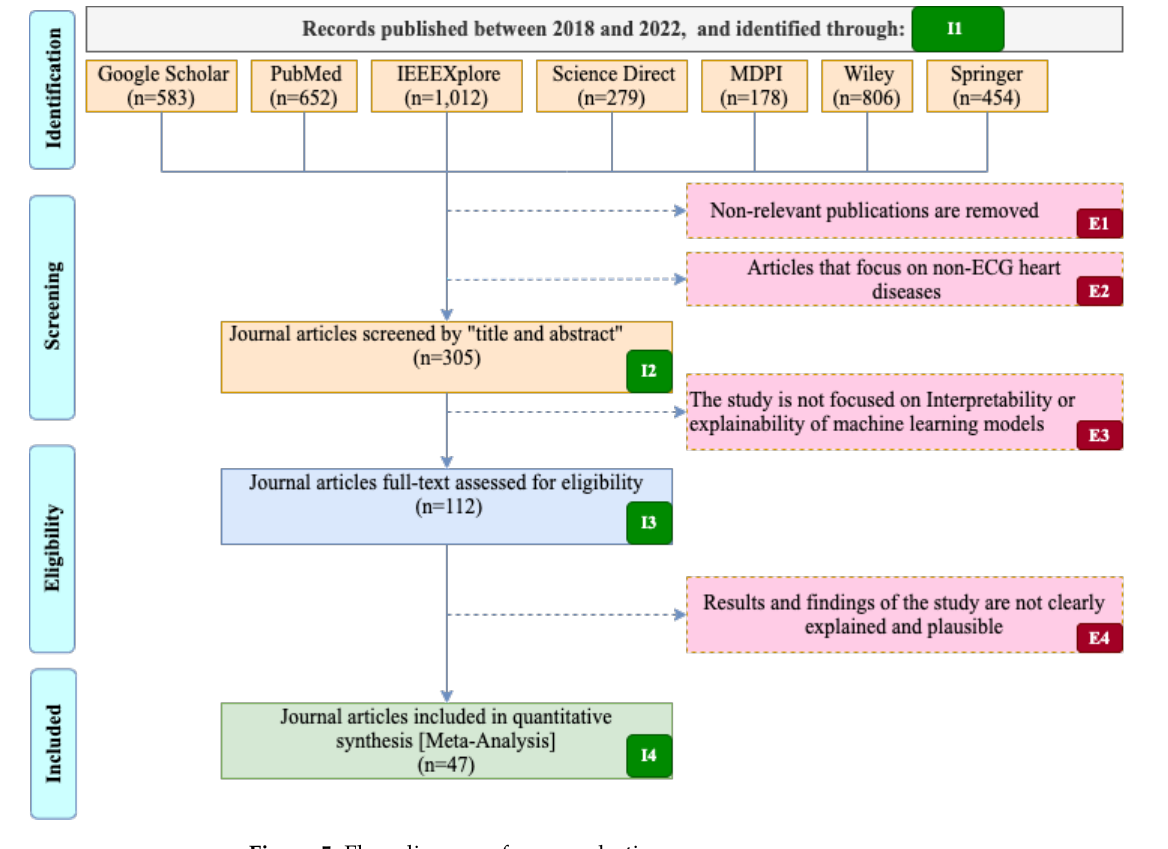
Figure 5. Flow diagram of paper